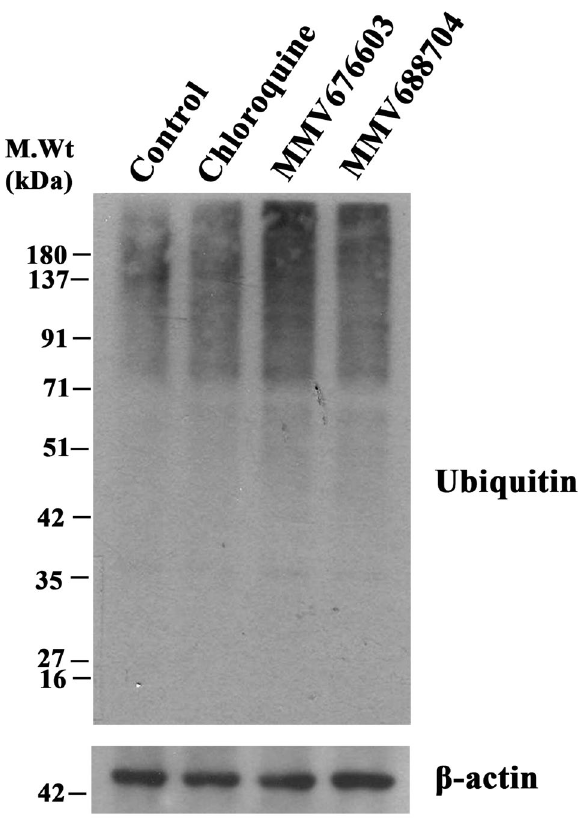
Figure 9. Effect of leads on ubiquitination levels: asynchronous P. falciparum culture was treated with vehicle control (Lane 1), Chloroquine (Lane 2) and identified compounds (MMV676603 (Lane 3), MMV688704 (Lane 4)). Following treatment, parasites were lysed and equal amount of parasite lysate was subjected to SDSPAGE and immunoblotting was carried out with ubiquitin antibody for ubiquitination levels. β-actin was kept as